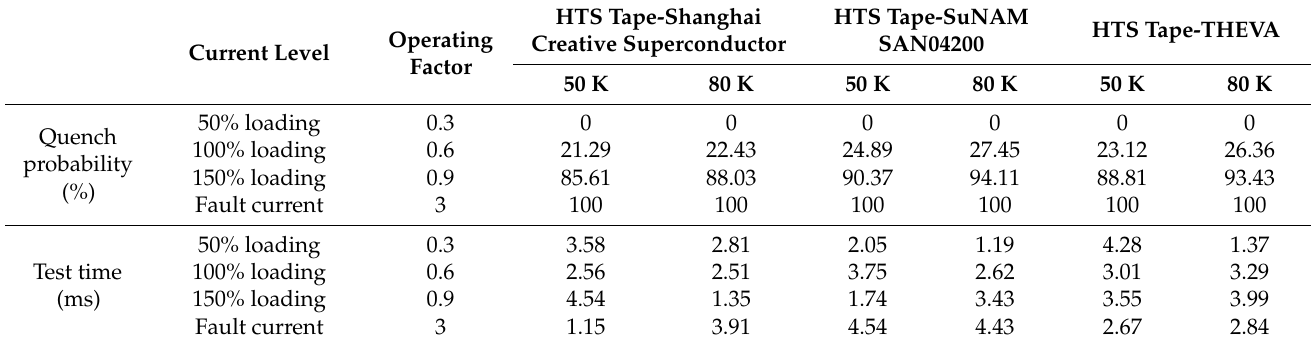
Table 2. The test performance of the proposed ANN model for quench probability estimation.